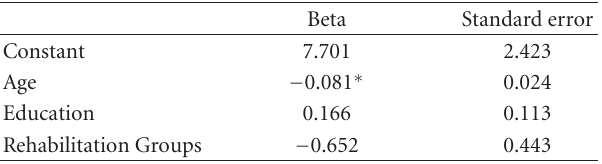
Table 3: Regression results for poststroke HDL activity participa-